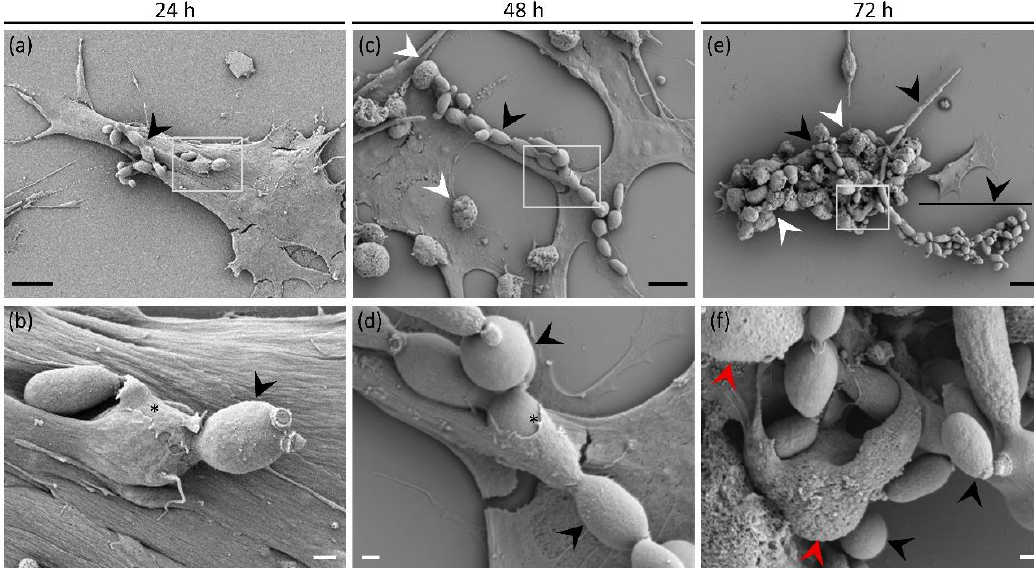
Figure 6. Internalization of Exophiala dermatitidis into neuroblastoma cells SH-SY5Y during three day co-cultivation observed by a scanning electron microscope (SEM). The columns represent 24 h, 48 h, and 72 h of co-cultivation of the fungus and SH-SY5Y cells. Images in the lower row depict enlarged insets of images above them. ( a ) Neuroblastoma cells attached to the surface after 24 h co-cultivation, with partially internalized pseudohyphae (black arrowheads) on their surface. ( b,d ) Note pseudopodia extending over fungal cell (asterisk). ( c,d ) Continuous growth of pseudohyphae (black arrowheads), their internalization, and ( c ) gradual degradation of neuroblastoma cells by formation of cell blebs (white arrowheads) on the cell surface, after 48 h of co-cultivation. ( e , f ) Degradation of neuroblastoma cells by extensive fungal growth seen as blebbing (white arrowheads) and ( f ) degradation of the cell membrane (red arrowheads) after 72 h of co-cultivation. Black and white scale bars represent 10 μm and 1 μm, respectively.